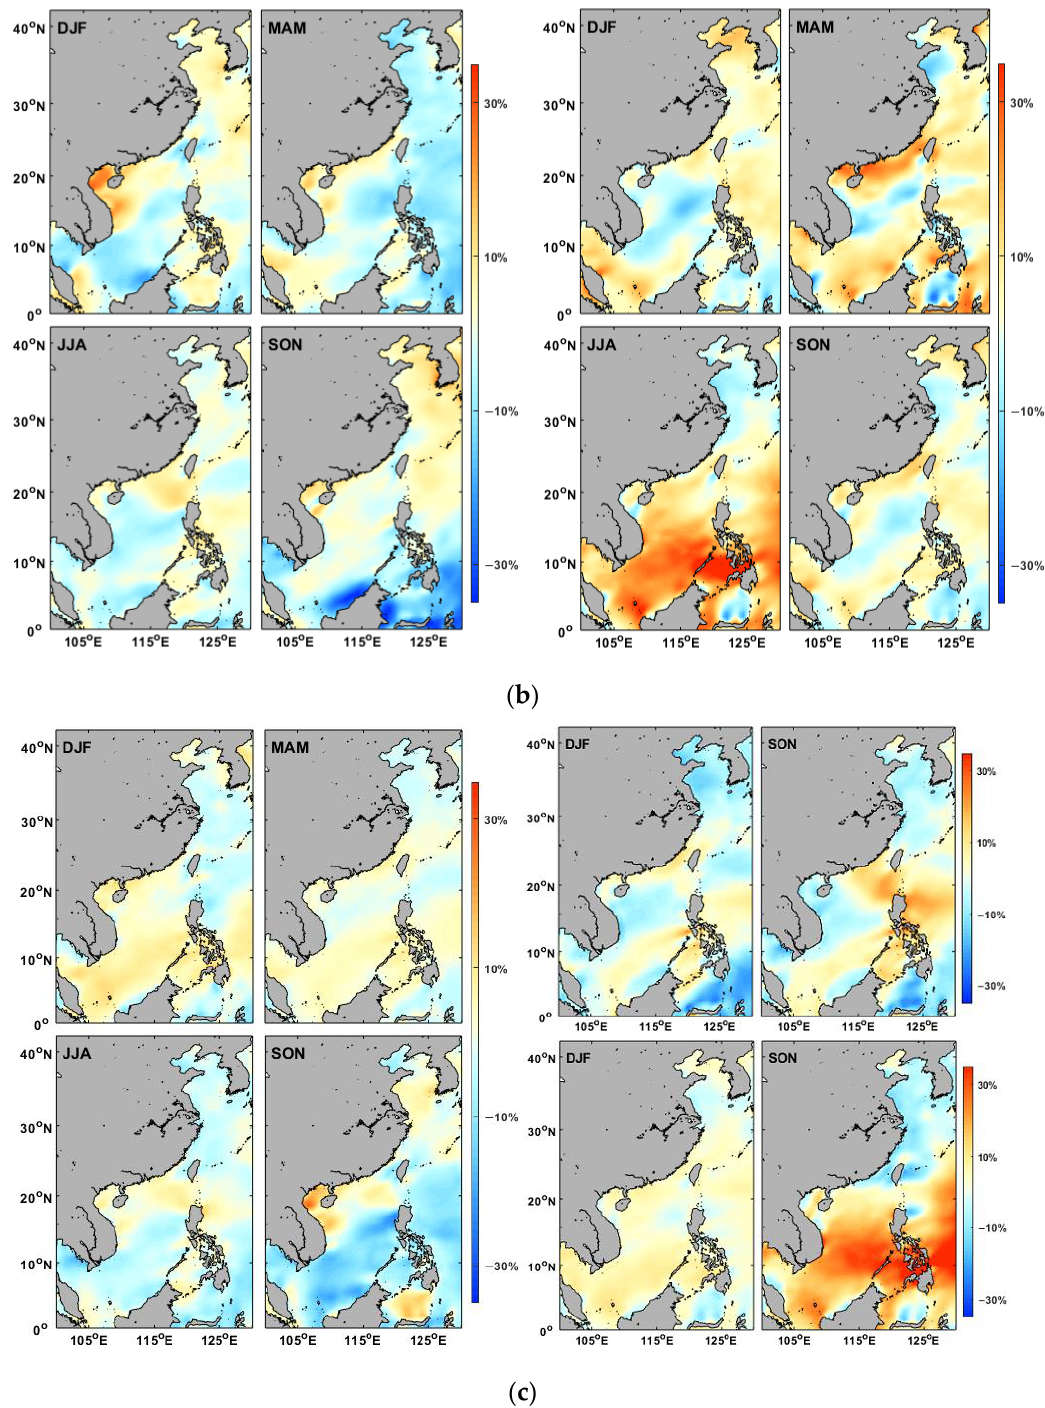
Figure 14. The percentage change in wind speed during different ENSO events: ( a ) weak El Niño (left) and La Niña (right), ( b ) moderate El Niño (left) and La Niña (right), and ( c ) strong El Niño (left), very strong (top right), and strong La Niña (lower right).